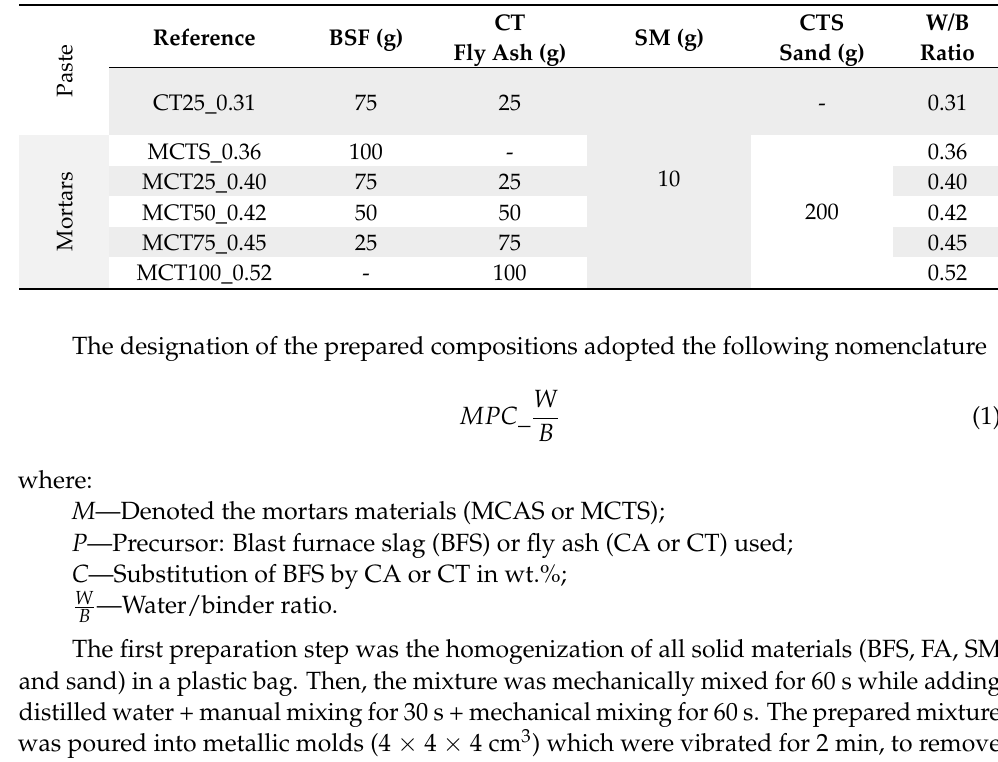
Table 3. Compositions of the prepared materials with residues from the CT boiler.